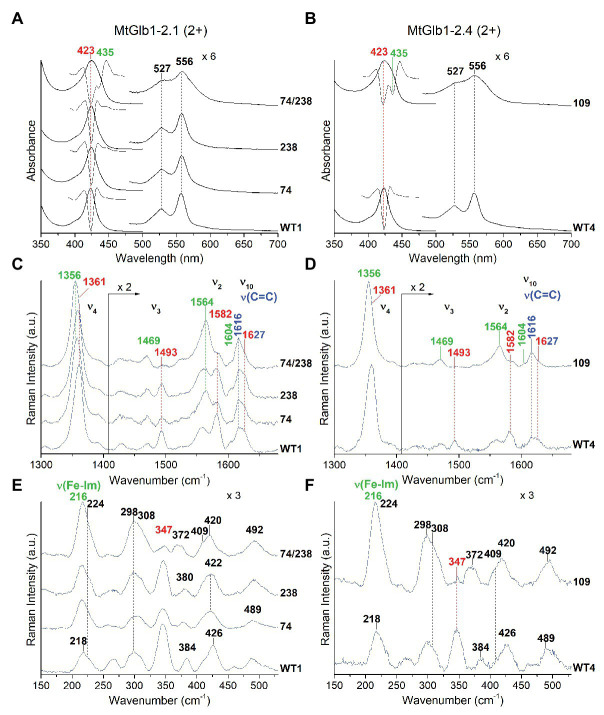
Spectroscopic characterization of the deoxyferrous form (2+) of MtGlb1-2.1 and MtGlb1-2.4. (A,B) UV-Vis and second derivative (D2) spectra in the Soret region together with RR spectra in the (C,D) high and (E,F) low frequency regions of deoxyferrous WT1, WT4, and their mutants. RR spectra were obtained with excitation at 441.6 nm. The wavelength of the Soret band and the wavenumbers of the RR marker bands of the 6cLS and 5cHS species and the RR vinyl v(C=C) stretching modes are reported in red, green, and blue, respectively. The spectra have been shifted along the y-axis. The 475–700 nm region of the UV-Vis spectra and the 1,430–1,700 cm−1 region of the RR spectra are expanded 6‐ and 2-fold, respectively, to facilitate visualization. The intensity of the RR spectra is normalized to the v4 band. RR experimental conditions: laser power at the sample 10 mW; and number of spectra used to calculate the average spectrum x integration time in minutes: (C) WT1 (3 × 9), 238 (6 × 18), 74 (6 × 30), and 74/238 (4 × 10). (D) WT4 (3 × 9) and 109 (6 × 18). (E) WT1 (4 × 20), 238 (3 × 18), 74 (4 × 16), and 74/238 (4 × 16). (F) WT4 (2 × 16) and 109 (3 × 15).